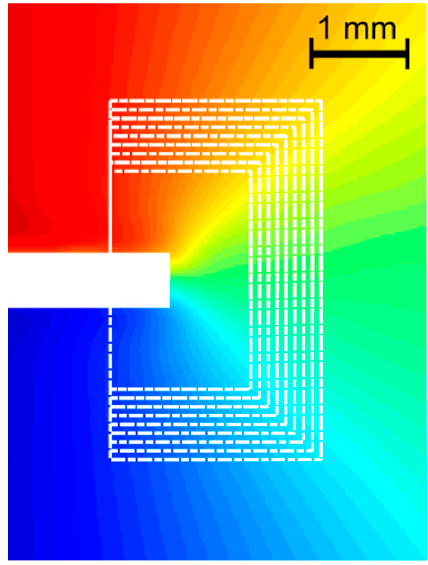
Figure 7. Paths considered in the computation of the J-integral.